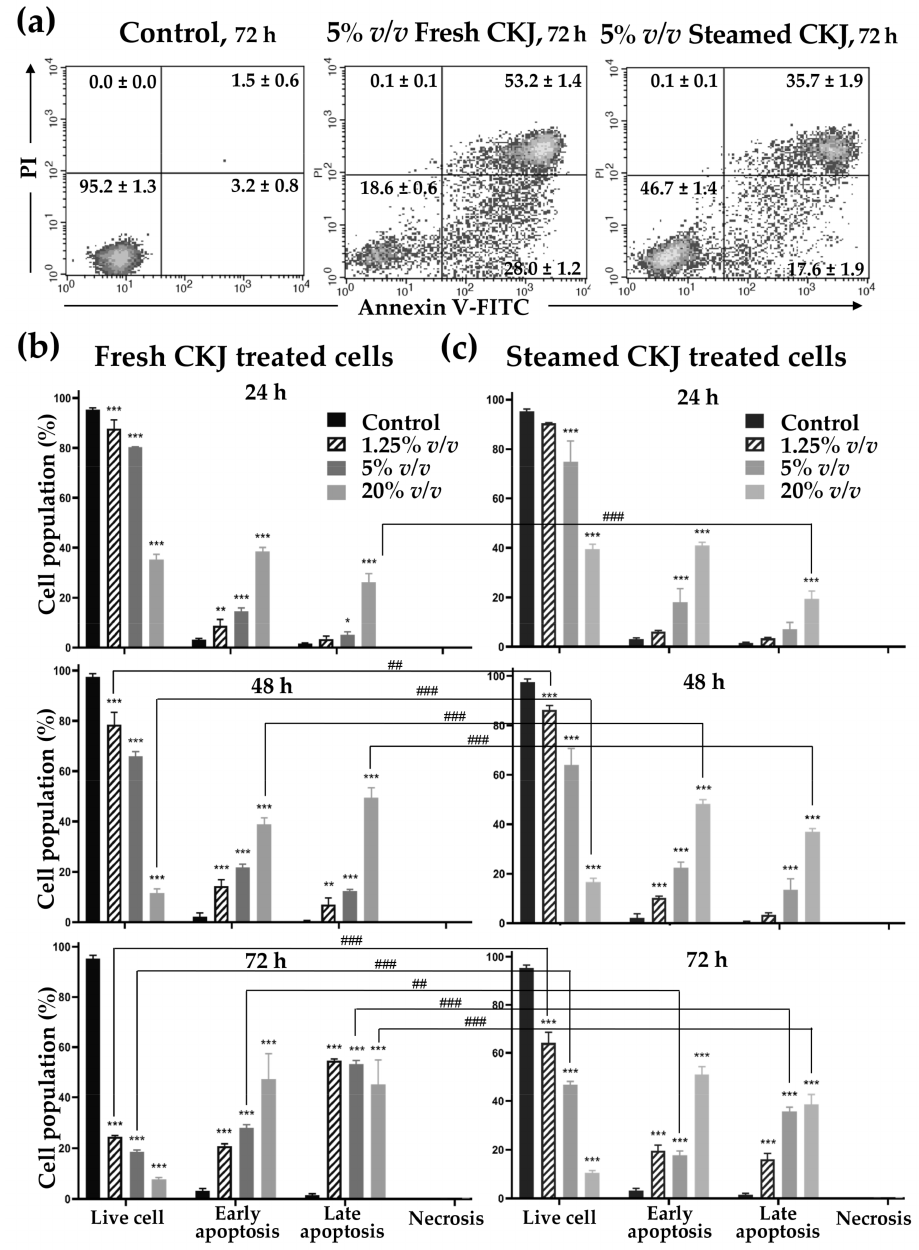
Figure 3. Induction of U937 cell apoptosis by fresh and steamed CKJ. The positive cells were quantified using a flow cytometer (lower left: live, lower right: early apoptosis, upper right: late apoptosis, upper left: necrosis) ( a ) The percentage of cells in each group was calculated ( b , c ). The significance level of the tested sets was compared with a control (normal saline) set (* p = 0.05, ** p = 0.01, and *** p < 0.001) and fresh CKJ-treated cells were compared with steamed CKJ-treated cells (## p = 0.01 and ### p < 0.001). Data are representative of at least three independent